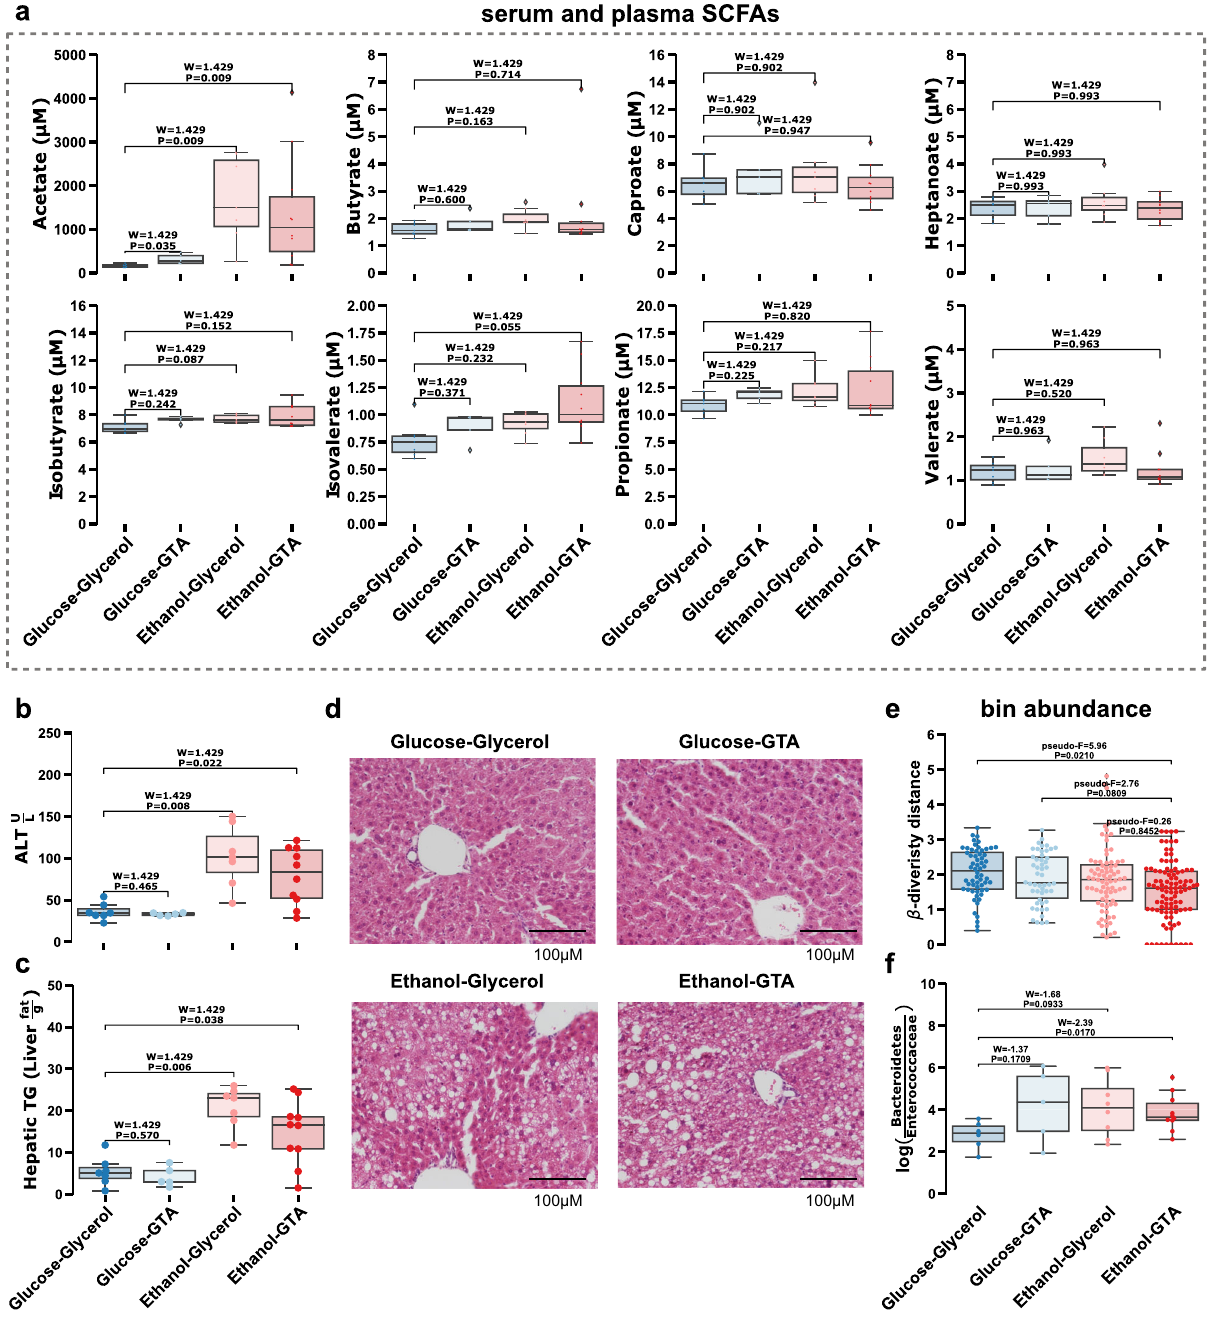
Fig. 4 Treatment of glyceryl triacetate (GTA) with or without alcohol arti fi cially enriches blood acetate and mimics microbial changes observed in ethanol only treatment but does not damage the liver. a Whole blood Short Chain Fatty Acid (SCFA) measurements, b serum alanine transaminase (ALT), c hepatic triglyceride (TG) liver damage measurements, and d representative sections of the liver after hematoxylin and eosin staining between intragastric feeding model of continuous infusion of ethanol or glucose with or without GTA in mice ( N = 4). Scale bar, 100 µ M. e Beta-diversity distance from Ethanol-GTA treatment group compared between treatment groups. p value determined by pairwise PERMANOVA between treatment groups. f The log-ratio of Bacteroides and Enterococcaceae (y-axis) compared between treatments (x-axis). Box plots represent the minimum, maximum, median, fi rst, and third quartile values (shaded region). Signi fi cance was evaluated by a two-sided Wilcoxon rank sum test with Tukey ’ s HSD post-hoc test adjusted p values of less than 0.05 were shown in the fi gure ( N = 29). Source data are provided as a Source Data fi absence of alcohol. These fi ndings indicate that acetate-induced alterations of the gut microbiota alone without alcohol are not